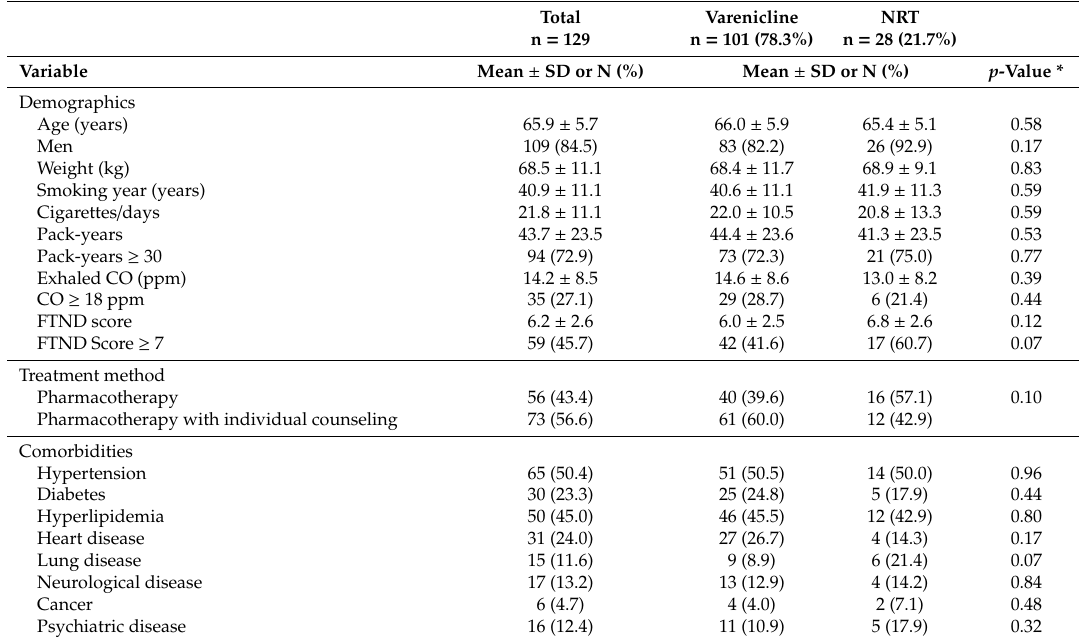
Table 1. Participants’ baseline